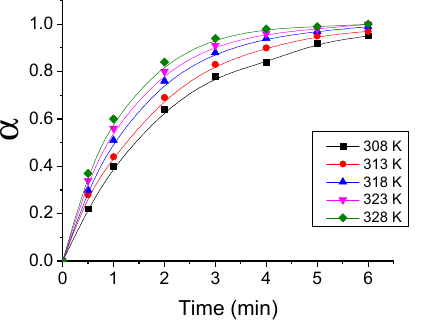
Figure 1 . Isothermal kinetic curves for NIAM release under SMHC . Figure 1. Isothermal kinetic curves for NIAM release under SMHC.